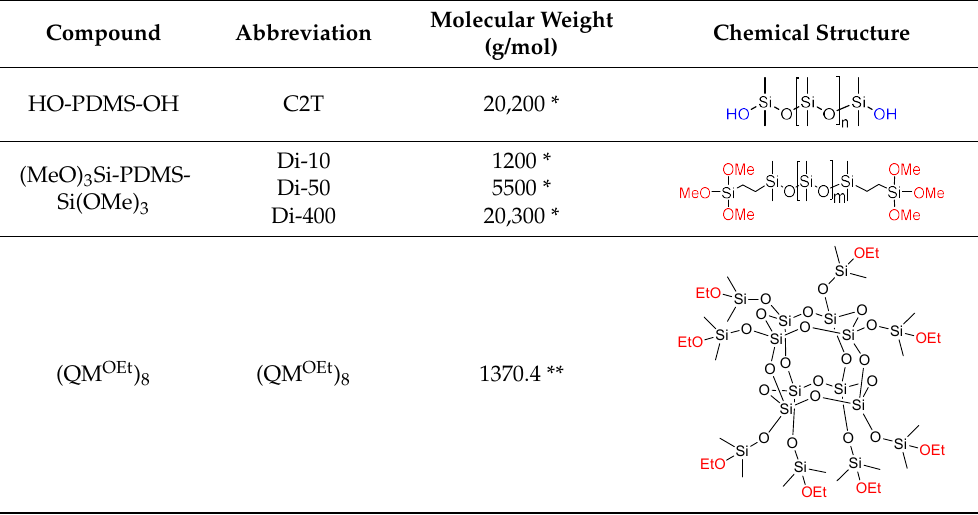
Table 1. Summary of compounds used in the elastomer formulations.